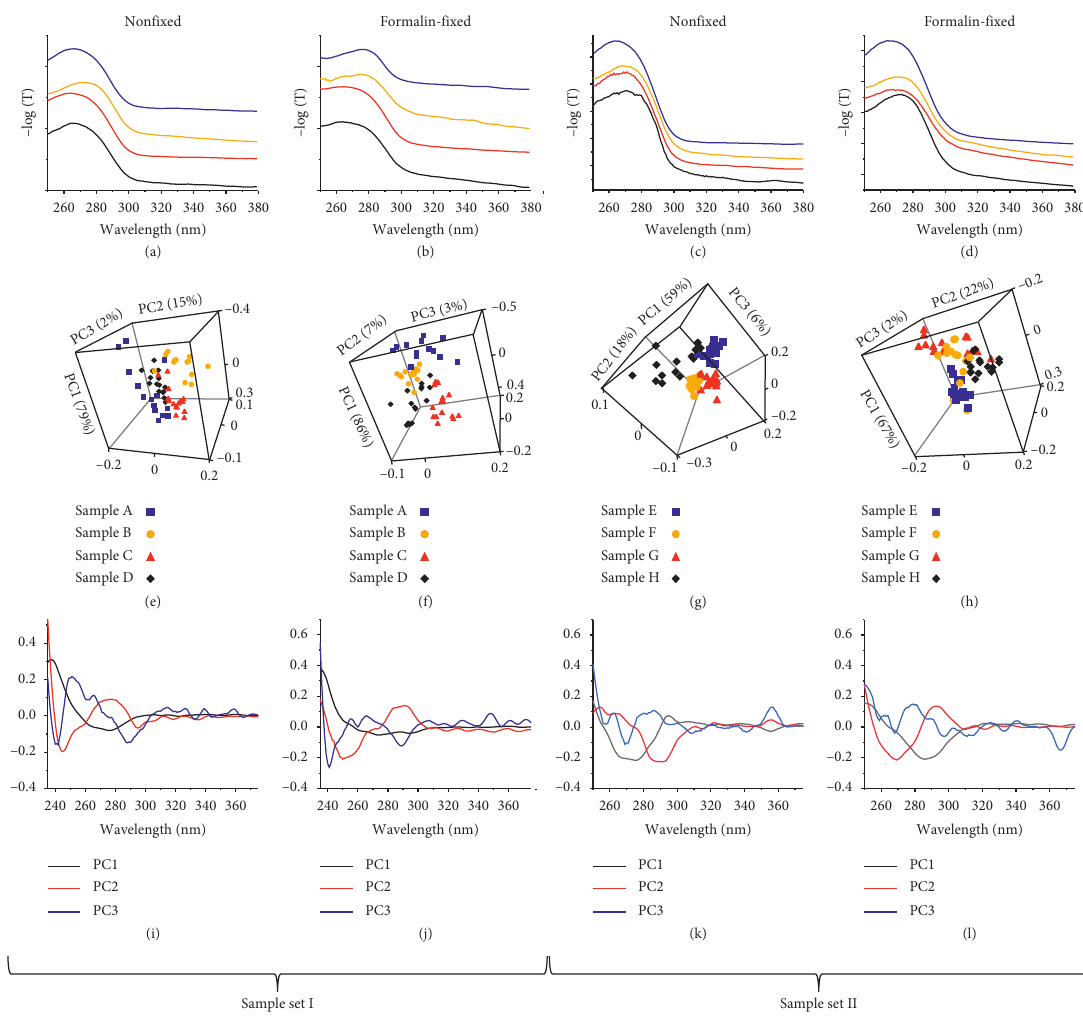
Figure 2: UV mean spectra and corresponding PCA models: UV absorption mean spectra of nonfixed (a, c) and formalin-fixed (b, d) brain tumour tissue cross sections in the range from 230nm to 380nm. The spectra are vertically displaced, and SNV transformed. (e) and (g) 3D scores plot with PC1 versus PC2 versus PC3 to differentiate between nonfixed tissue samples. (f) and (h) 3D scores plot with PC1 versus PC2 versus PC3 to differentiate between formalin-fixed tissue samples. The representative tumour entities for the tissue samples A to D with different malignancies are fibrous meningioma (sample (A)), oligodendroglioma (sample (B)), anaplastic ependymoma (sample (C)), and glioblastoma (sample (D)). The representative tumour entities for the tissue samples E to H with different malignancies are plexus papilloma (sample (E)), oligodendroglioma (sample (F)), anaplastic oligodendroglioma (sample (G)), and glioblastoma (sample (H)). Corresponding loadings plots of PC1 (black), PC2 (red), and PC3 (blue) for nonfixed (i, k) and formalin-fixed (j, l) cross